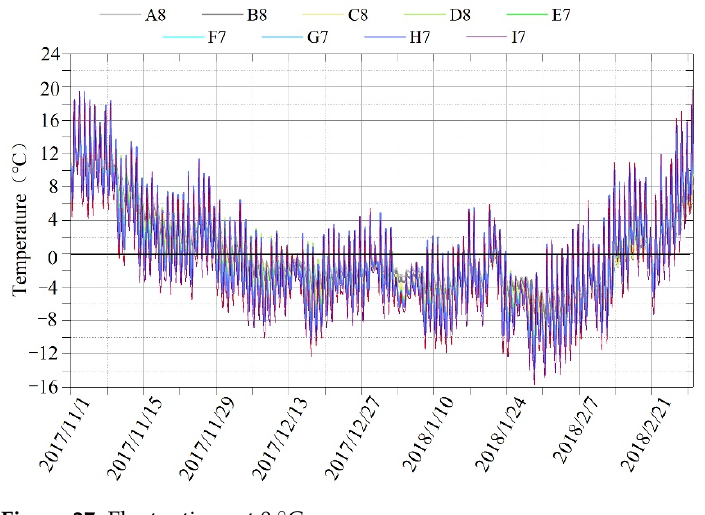
Coatings 2022 , 12 , x FOR PEER REVIEW Figure 27. Fluctuations at 0 °C. Figure 27. Fluctuations at 0 ◦ C.